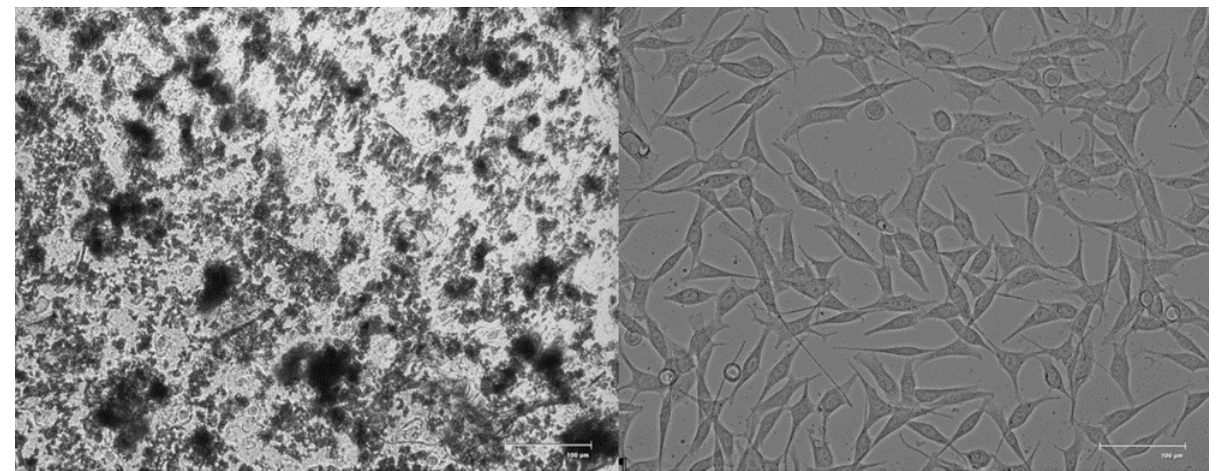
Figure 6. Comparison of melanoma cells with extract and without the presence of extract (FLoid Cell Imaging Station